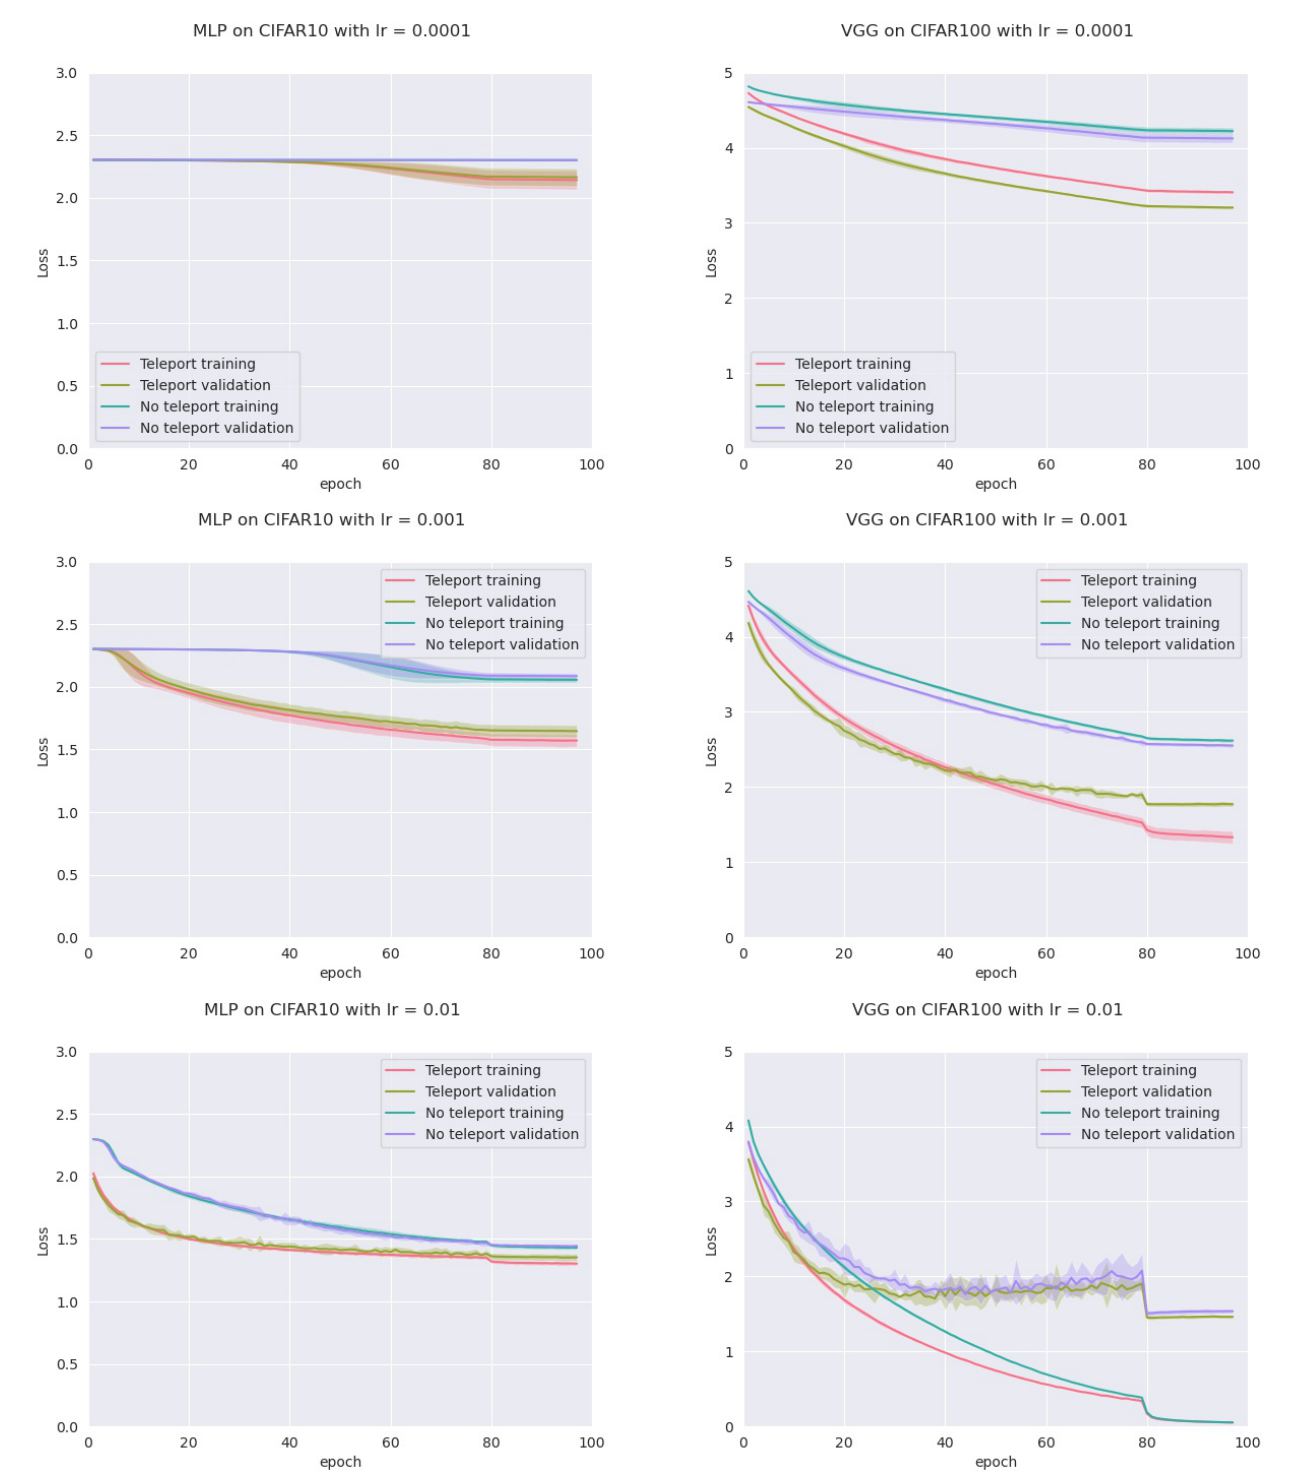
Figure A7. Average loss of MLP on CIFAR10 ( left ) and VGG on CIFAR100 ( right ) over 5 experiments, with and without teleportation, at the beginning of the training with CoB of 0.9. Learning rate increases from top to bottom rows. We also show a shadow around the average curves at two times the standard deviation over the five